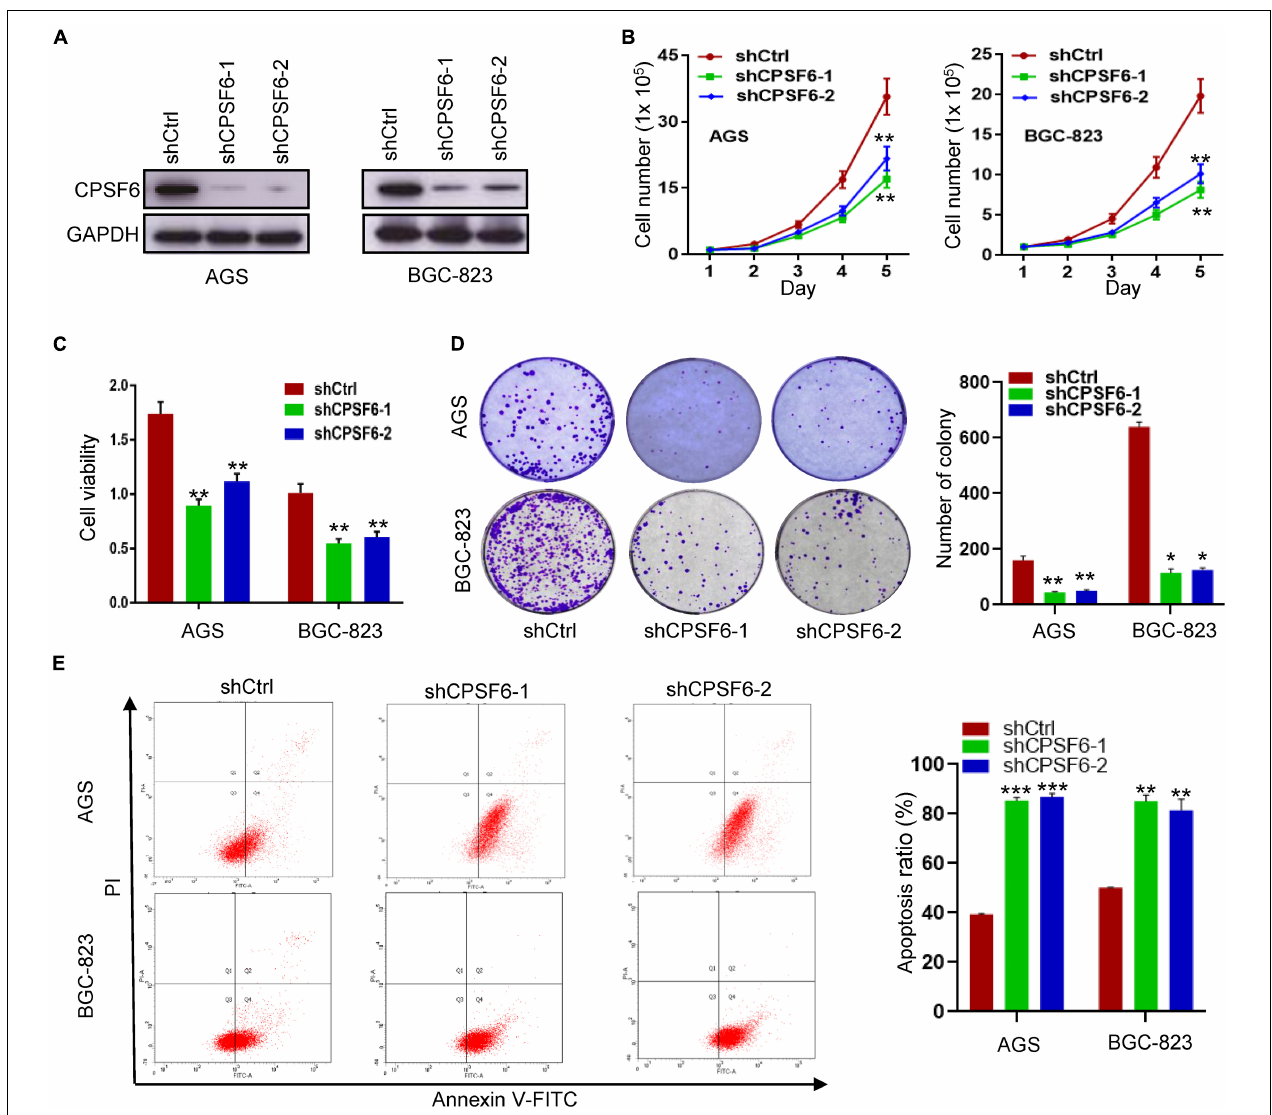
FIGURE 2 | CPSF6 promotes cell growth and inhibits apoptosis in GC cells in vitro . (A) Western blotting analysis of CPSF6 expression in AGS and BGC-823 cells stably transfected with shRNA plasmids. (B,C) Detection of cell proliferation and viability after knockdown of CPSF6 in AGS and BGC-823 cells. (D) Detection of colony formation after knockdown of CPSF6 in AGS and BGC-823 cells. (E) Detection of apoptosis in AGS and BGC-823 cells. *0.01 < p < 0.05; **0.001 < p < 0.01; *** p < 0.001.